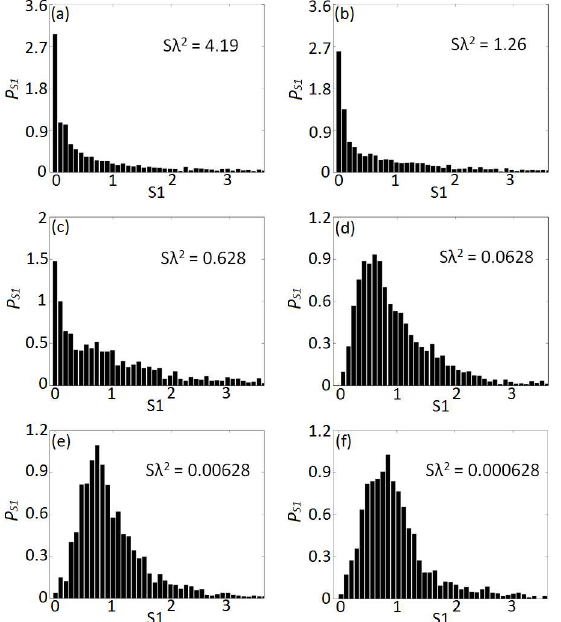
Figure 15. Level statistics of first-neighbor eigenvalues in the complex plane for an N = 1000 µ -spiral array with S λ 2 values as indicated in the panels. The value of first level spacing, S 1 , is computed at the nearest neighbor distance between eigenvalues in the complex plane for each eigenvalue, and is normalized by the average S 1 for each case. The probability density is normalized such that the total probability equals to